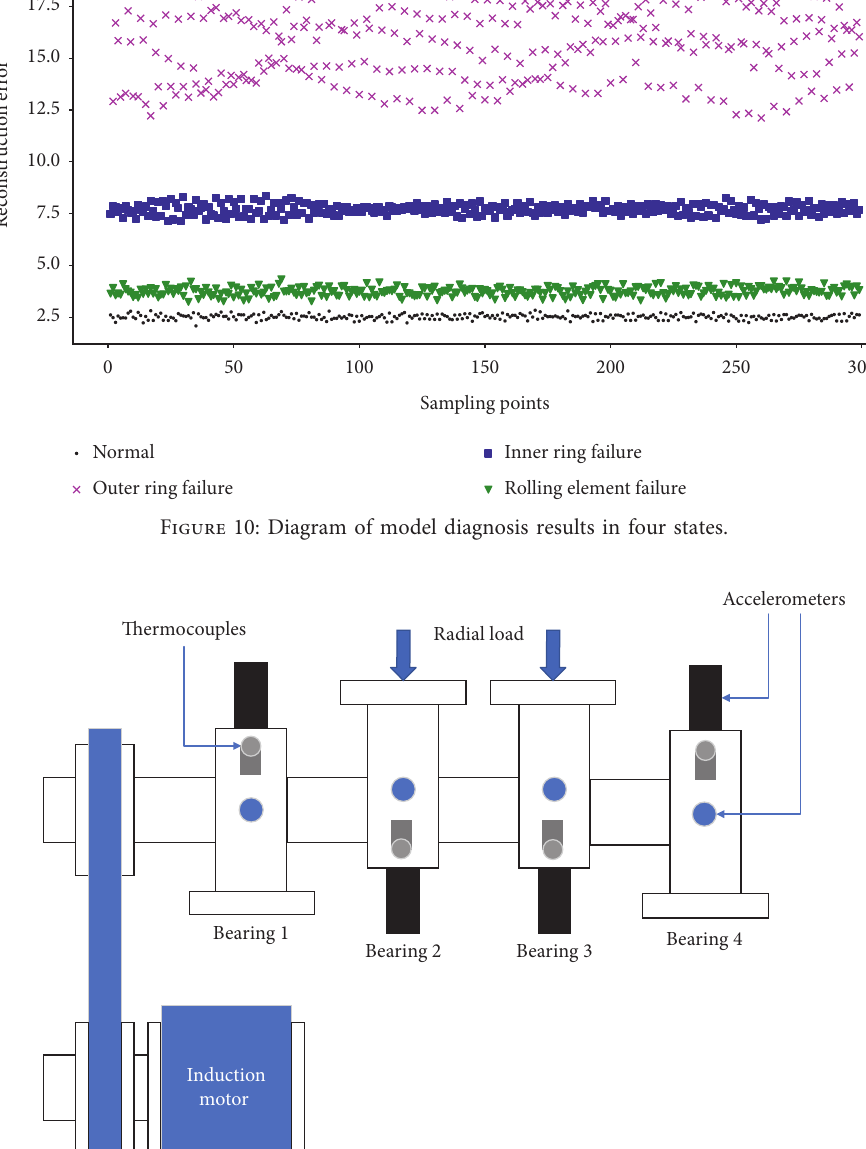
Figure 11: IMS full life cycle test